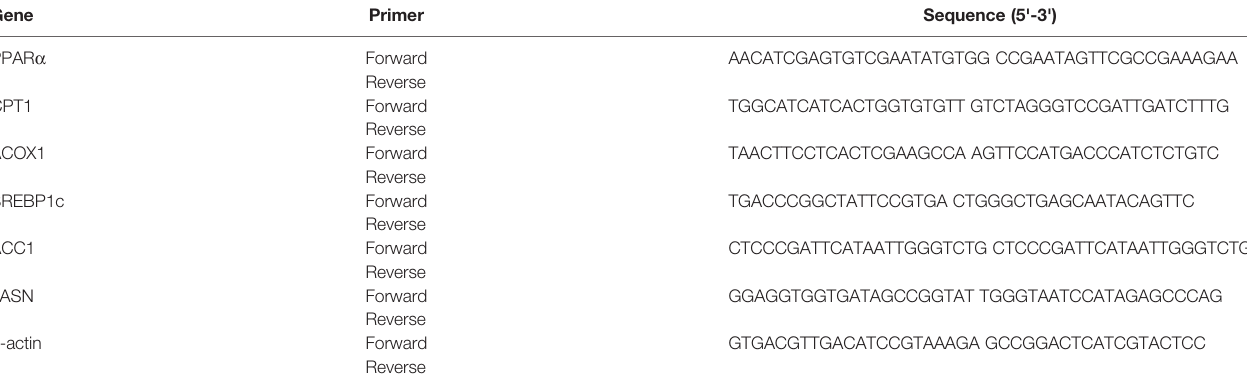
TABLE 1 | Primers used for real-time